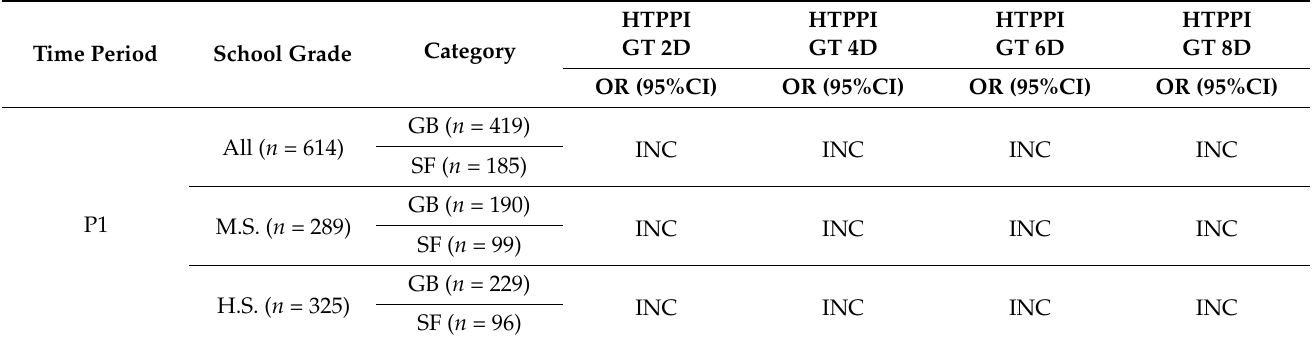
Table 3. Potential SARS-CoV-2 infection in school classes SF vs. GB, using different hypothesized generation